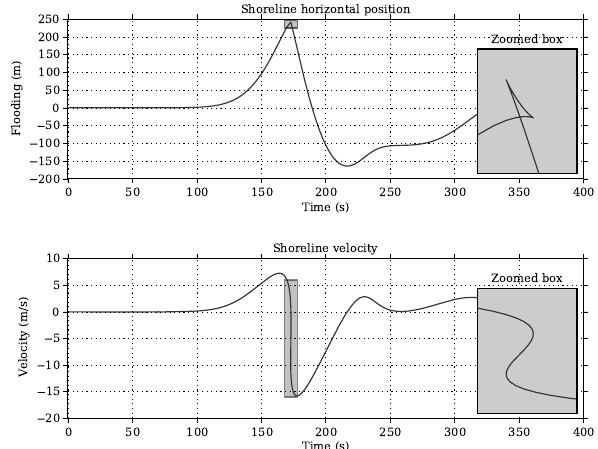
Fig. 4. Benchmark n. 1: critical points of the original version of the benchmark problem. A triplication in the curves representing the instantaneous shoreline position and velocity is visible around 170– 180s (see the inboxes) and shows that the analytical solution loses its physical meaning after that time. This multiple-value solution cannot be reproduced by any numerical